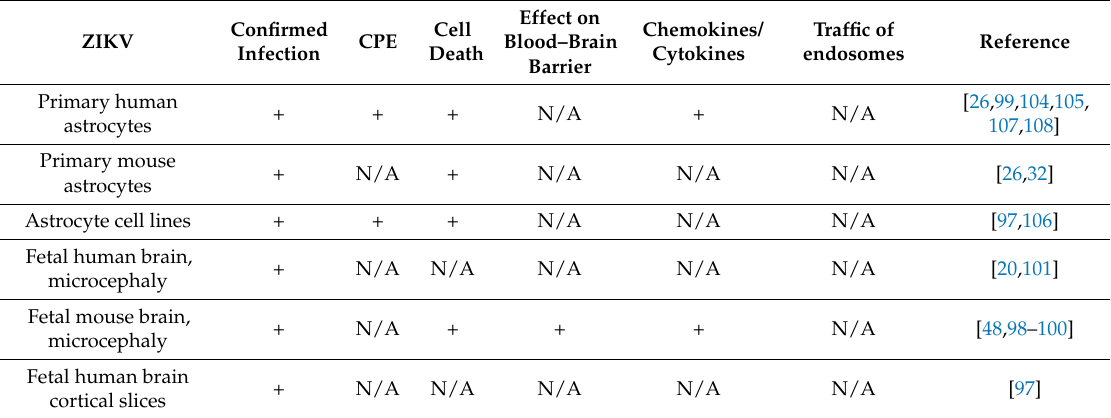
Table 3. Zika virus (ZIKV) infection induced changes in astrocytes and whole